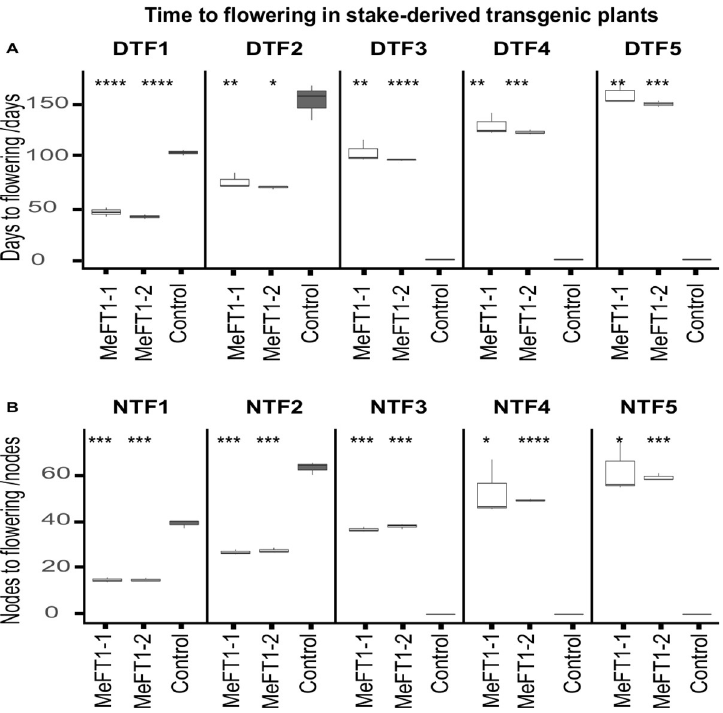
Fig 4. Flowering time in MeFT1 overexpressing and somatic embryo-derived control plant lines of cultivar 60444. ( A ) Days to first, second, third, fourth and fifth (DTF 1–5) flowering cycles, ( B ) number of nodes produced by plants prior to the first, second, third, fourth and fifth (NTF 1–5) flowering cycles. MeFT1-1 and MeFT1-2 are transgenic plant lines while SE is a somatic embryo-derived non-transgenic control. n = 30 independent plants per plant line. Two-way Student’s t test was performed to compare means of transgenic and non-transgenic embryo derived controls. � P � 0.05; �� P � 0.01; ��� P � 0.001, ���� P � 0.0001. ggplot2 of R software was used to construct box plots. The middle line in the box shows the median value. Data ranging from smallest value to lower quartile represents lower whisker while values between upper quartile and largest correspond to upper whisker. Values below and above median represent lower and upper quartile of roughly 1.5IQR